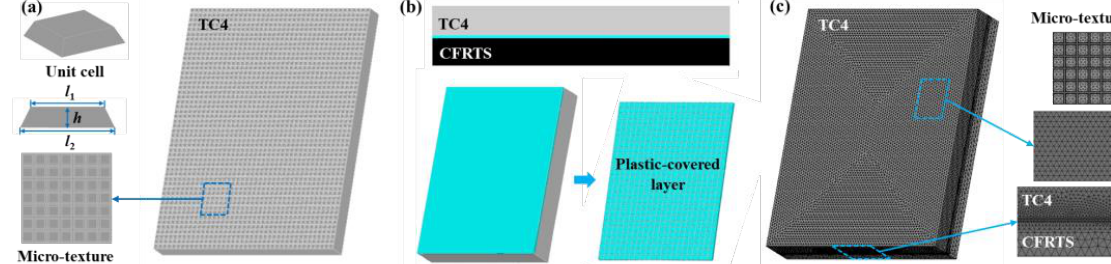
Figure 6. ( a ) Micro-texture geometric model; ( b ) anchorage model; ( c ) meshing model.